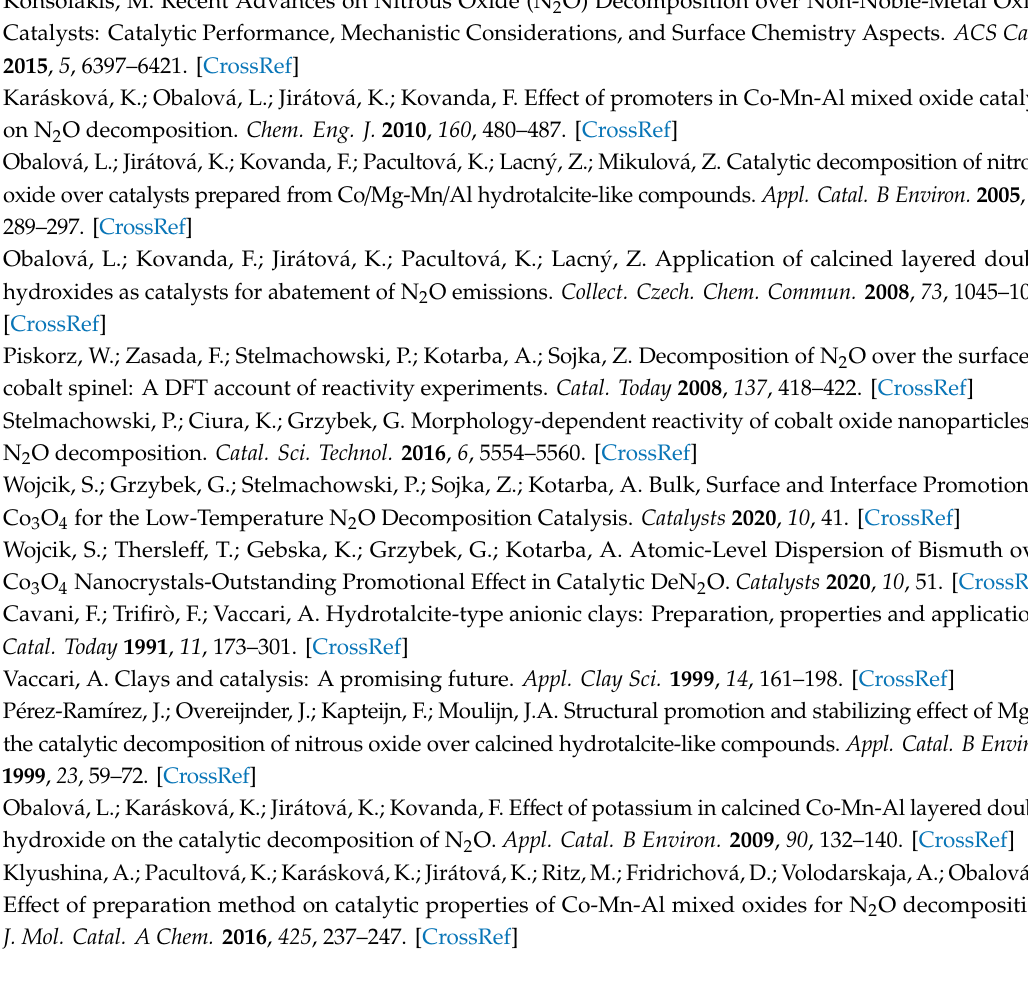
Figure S1: Deconvoluted XPS spectra of the individual elements of the catalysts, Figure S2: Signal of NO formed during TPD-CO 2 analysis over K / Co 4 MnAlO x